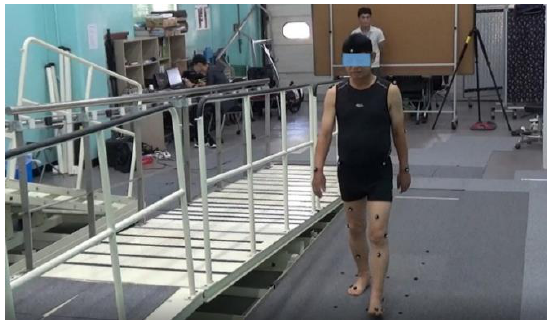
Figure 2. Example of measuring the walking characteristics of the elderly.